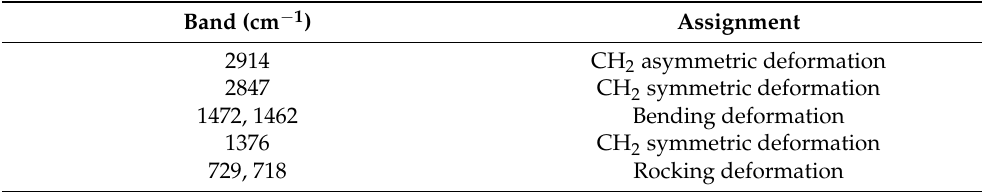
Table 2. Main absorption bands of polyethylene in the IR region and their